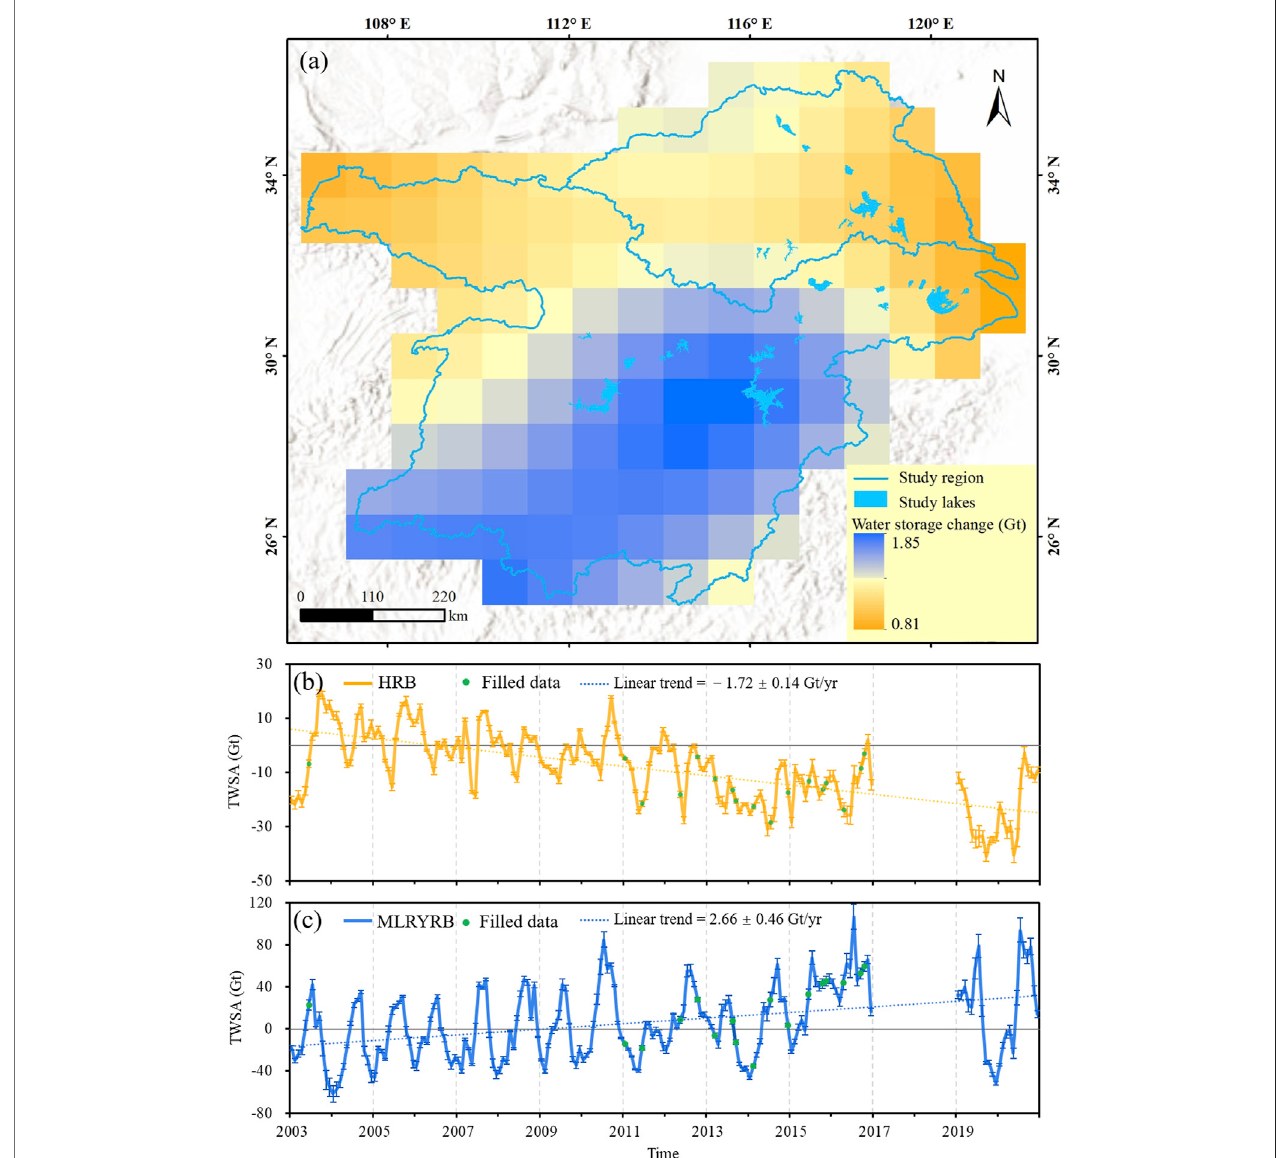
FIGURE 6 | Spatial-temporal patterns of seasonal amplitude and the linear trends for TWS in the YHRB derived from the GRACE observations between 2003 and 2020, except for 2017 and 2018. (A) Spatial distribution of the seasonal amplitude of TWS in the YHRB; (B) Long-term variation characteristics of GRACE TWSA in the HRB; and (C) Long-term variation characteristics of GRACE TWSA in the MLRYRB.